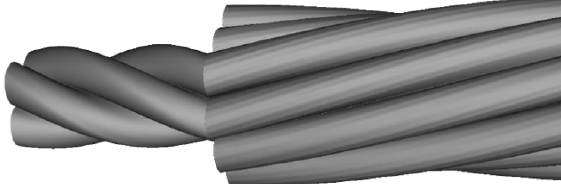
Figure 1. Schematic diagram of twisted Al wire.